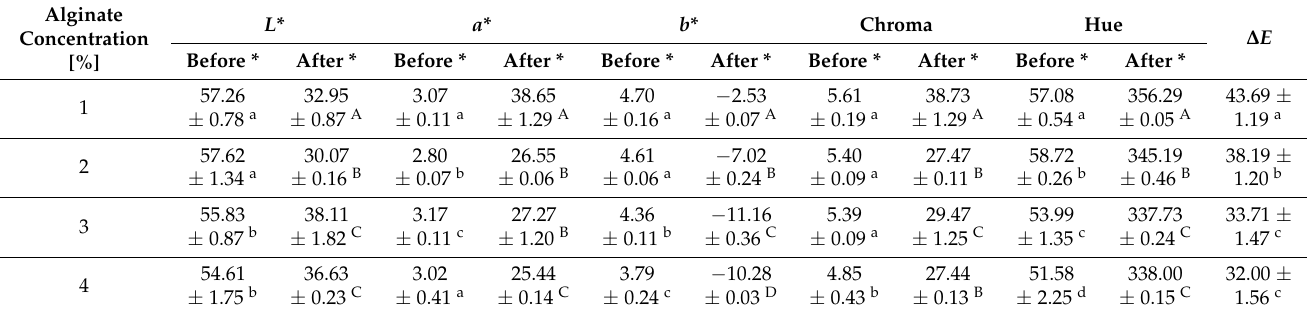
Table 1. Color parameters of the beads before and after adsorption. Different letters (a,b,c,A,B,C) in the superscript in the same column represent significant differences at p < 0.05. (*—all samples before and after adsorption were statistically significantly different at p <